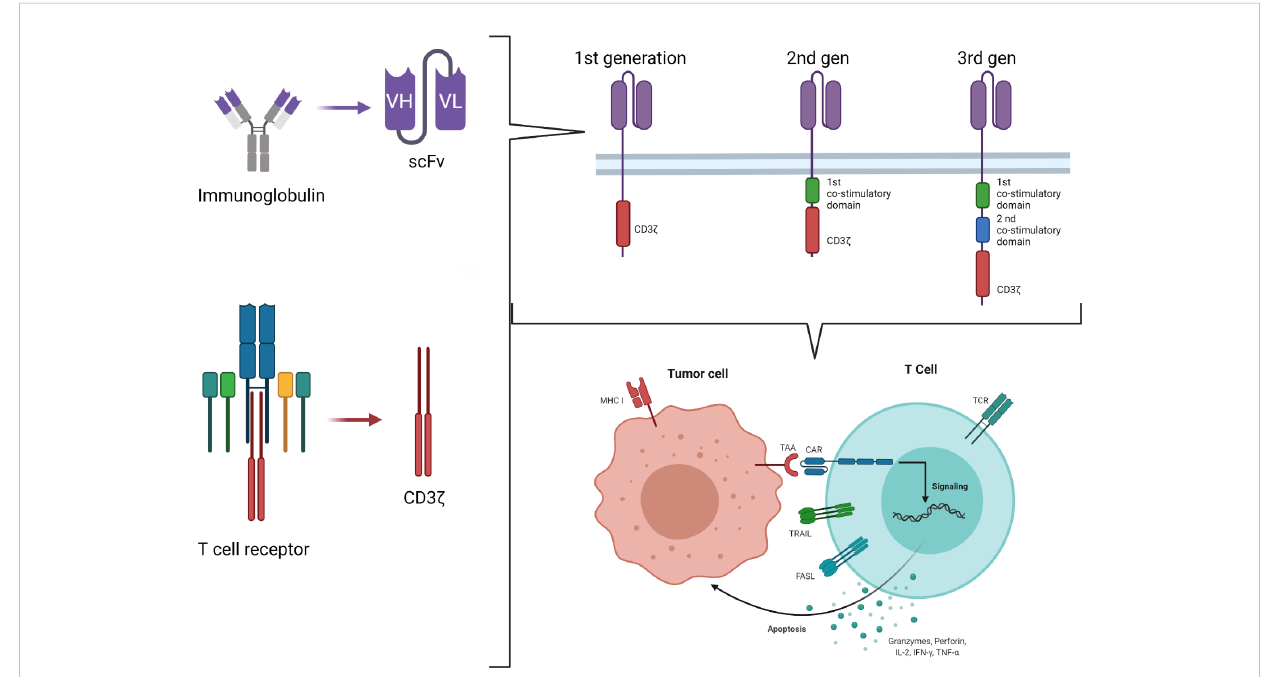
FIGURE 1 Second and third generation CAR-T cell